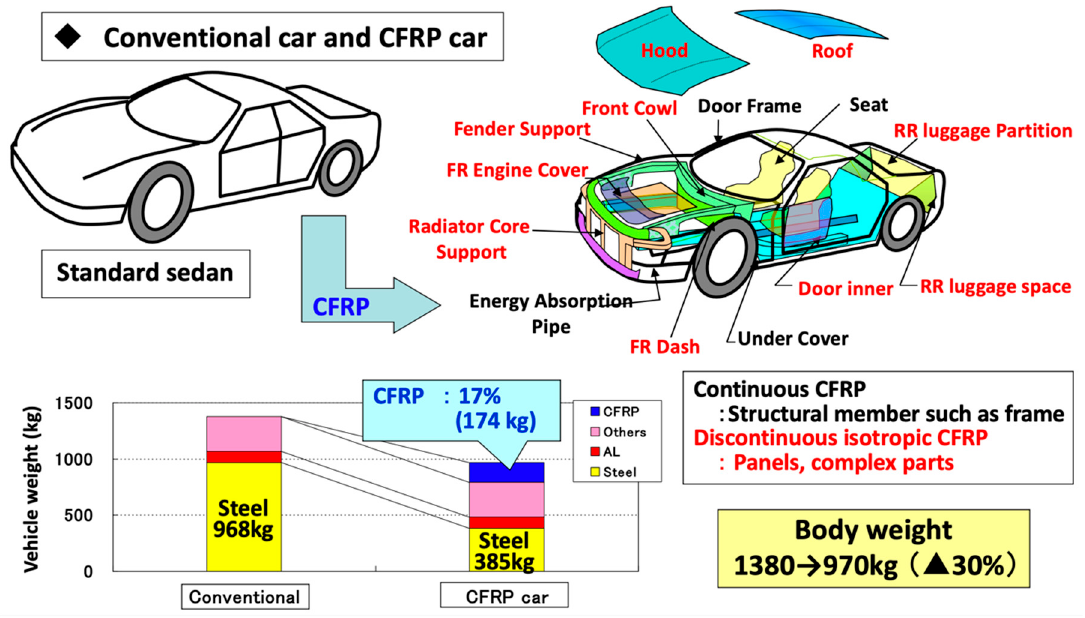
Figure 1. Weight reduction of automotive using carbon fiber-reinforced polymers (CFRPs).